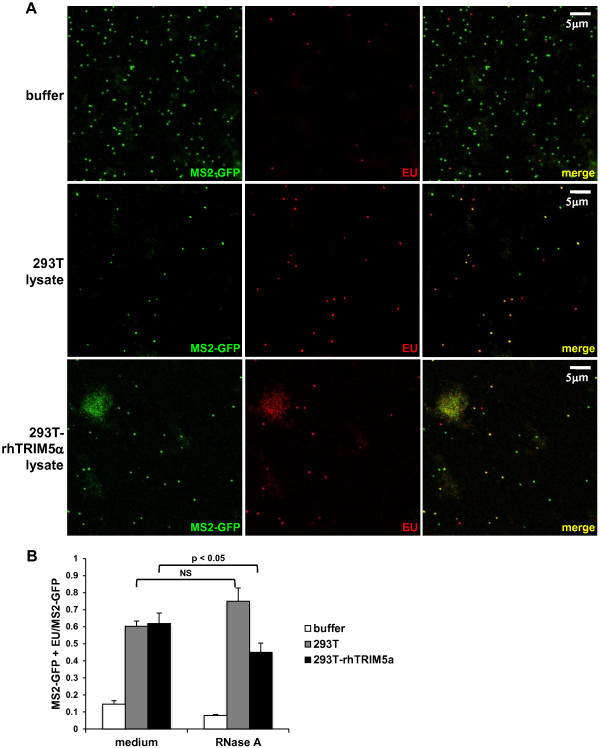
EU staining of HIV-1 RNA in vitro. (A) EU-labeled virus encoding MS2-binding sites and produced in the presence of MS2-GFP (green) was treated with cell extraction buffer, 293T cell lysate, or 293T cell lysate containing rhTRIM5α for 15 minutes, fixed onto slides, and then stained for EU (red). Particles were visualized by fluorescent confocal microscopy and shown for each individual color and with both colors (merge). (B) MS2-GFP+ and EU+ virions were counted per field after treatment with buffer, 293T cell extract, or 293T cell extract expressing rhTRIM5α in the presence of 10 μg/ml RNase A. Data represent the ratio of double positive particles of the total counted MS2-GFP+ particles ± SEM of at least 4 fields. Results are representative of 2 independent experiments. A student’s t test was performed on medium vs. RNase A treatment of virions incubated with either 293T or 293T-rhTRIM5α lysate. NS denotes a non-significant p value (>0.05).